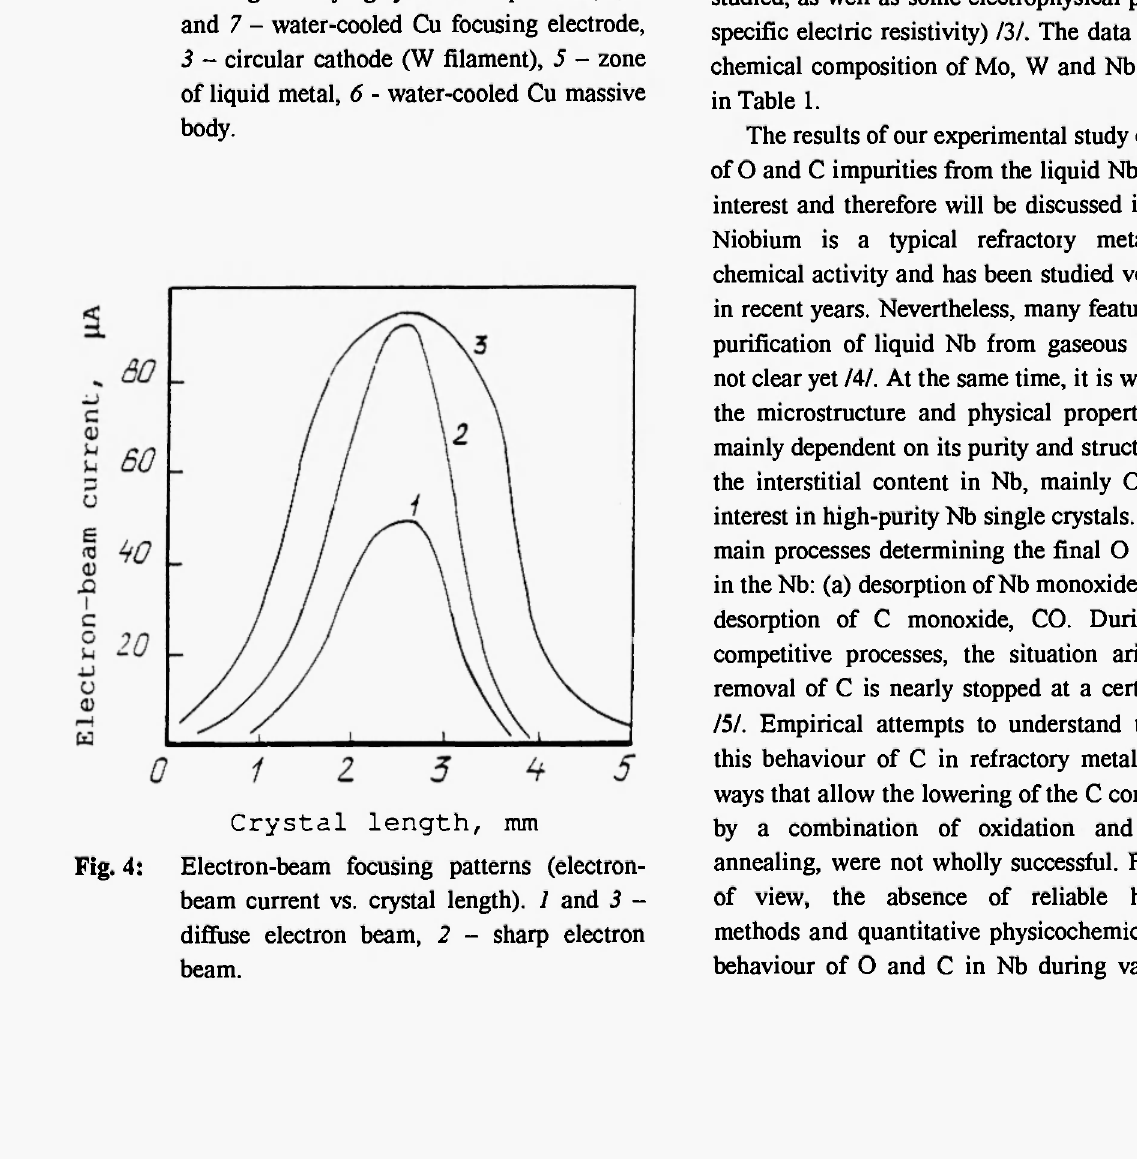
Fig. 3: Schematic diagram of circular electron-beam gun for crystal growth by EBFZM. 1 - melting/solidifying cylindrical specimen, 2, 4 and 7 - water-cooled Cu focusing electrode, 3 - circular cathode (W filament), 5 - zone of liquid metal, 6 - water-cooled Cu massive body.